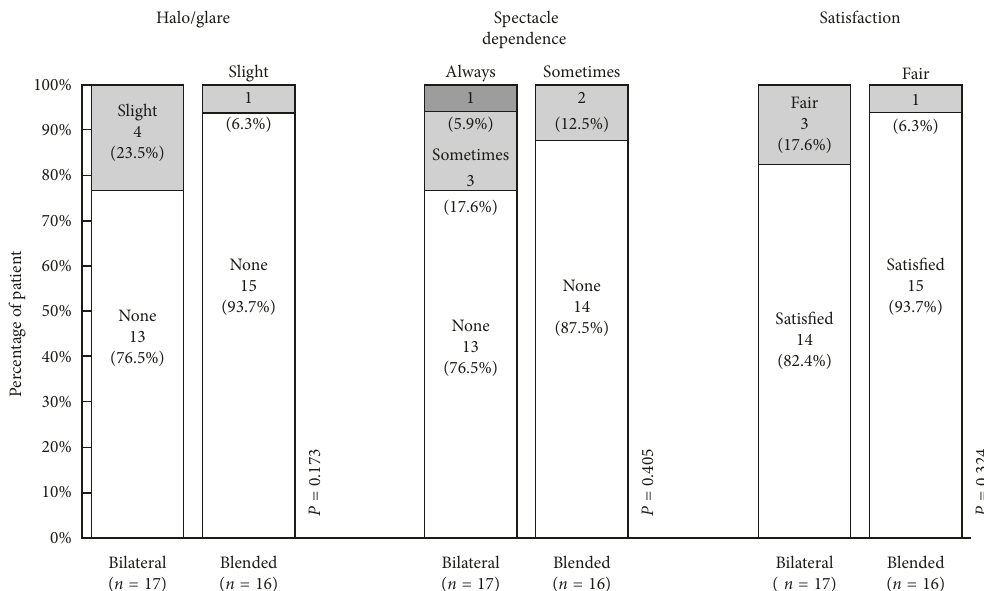
Figure 3: Concise postoperative quality-of-vision questionnaire. Levels: halo/glare, none/slight/severe; spectacle dependence, none/ sometimes/always; and satisfaction,